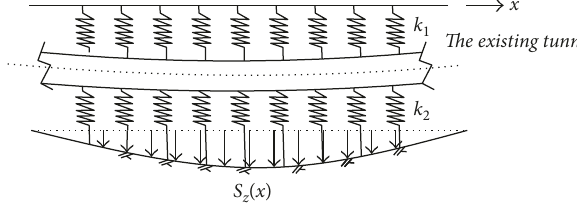
Figure 13: A schematic view of the existing tunnel-soil tunnelling